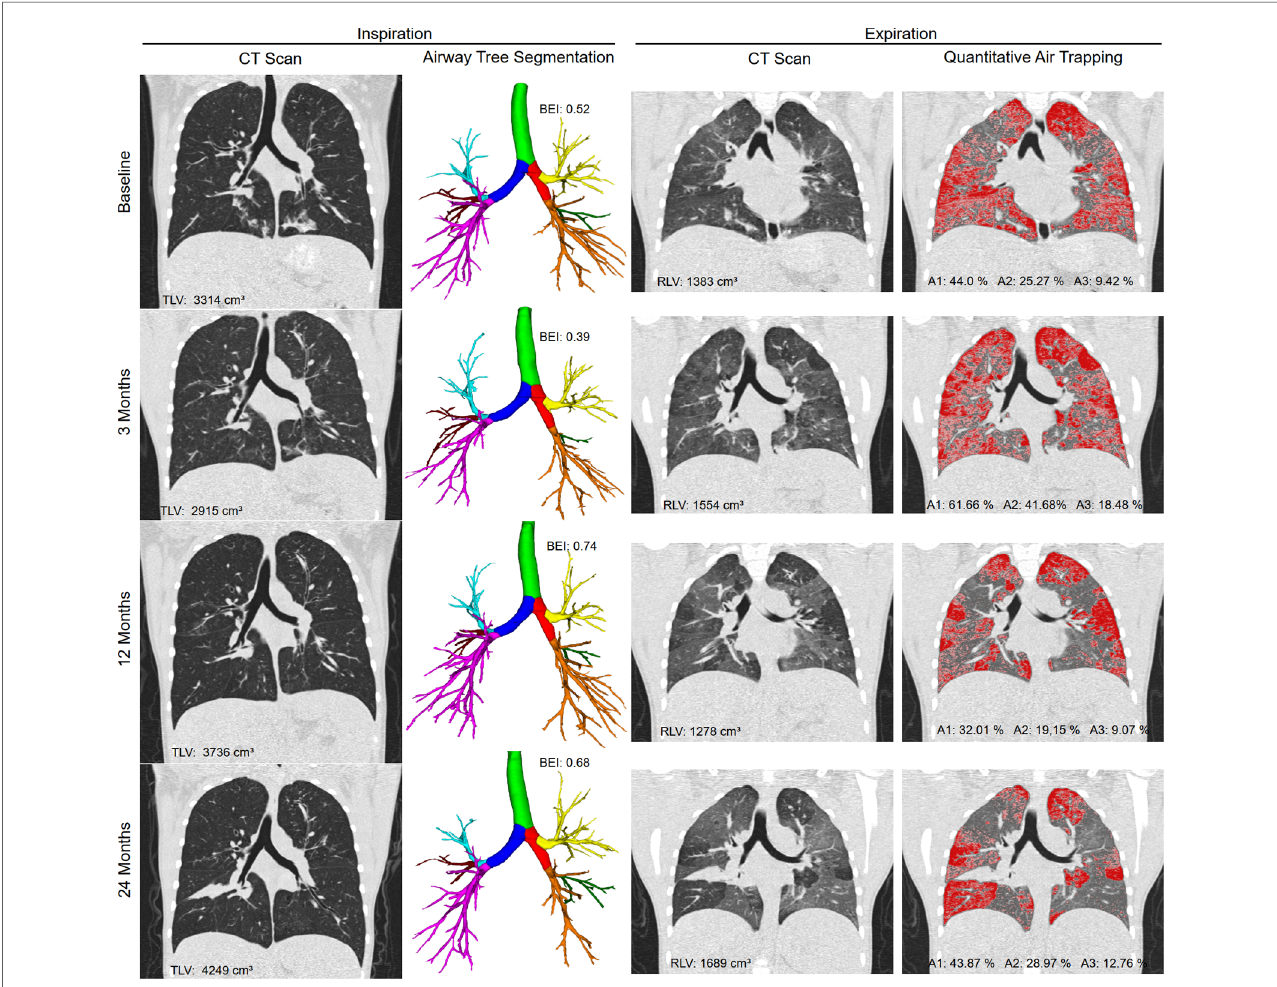
FIGURE 4 Representative example of a 10-year-old female cystic fi brosis patient scanned with paired inspiratory-expiratory CT at baseline, and subsequently after 3, 12 and 24 months. The fi rst column shows the inspiratory CT in coronal reconstruction and the second column the segmentation results of the airway tree including labeling of the pulmonary lobes (trachea highlighted in green, right main in red, left main in dark blue, right upper lobe in yellow, middle lobe in green and right lower lobe in orange, left upper lobe in light blue, lingula in red, and left lower lobe in pink). The third column shows the expiratory CT in coronal reconstruction and the fourth column the results of air trapping quanti fi cation using the A1 (A1 includes A2 and A3) parameter. The quantitative results TLV, BEI, RLV, A1, A2, A3 are given for each timepoint. BEI increased from 0.52 to 0.68, and A3 from 9.42% to 12.76% over tow years. The corresponding ppFEV1 were 104% and